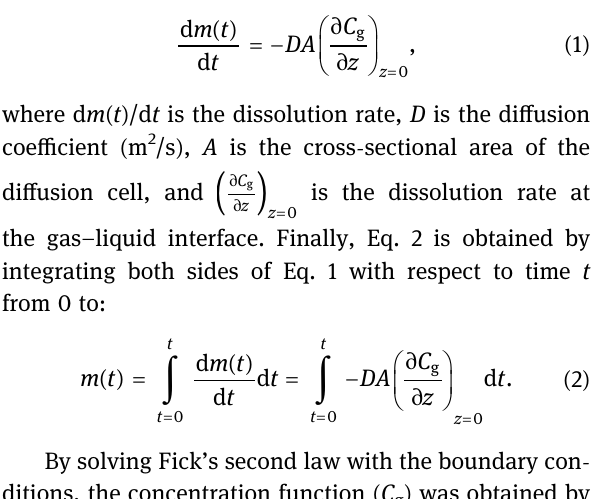
Figure 2: Diagram of the di ff usion